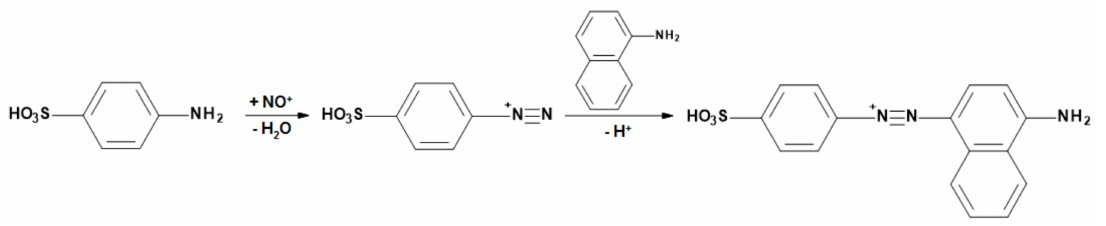
Figure 4. Partial reactions in the Saltzman method: the nitrosyl cation causes sulfanilic acid and NED to form an azo dye (red-violet). In this case, the first step is the diazotization reaction, in which a